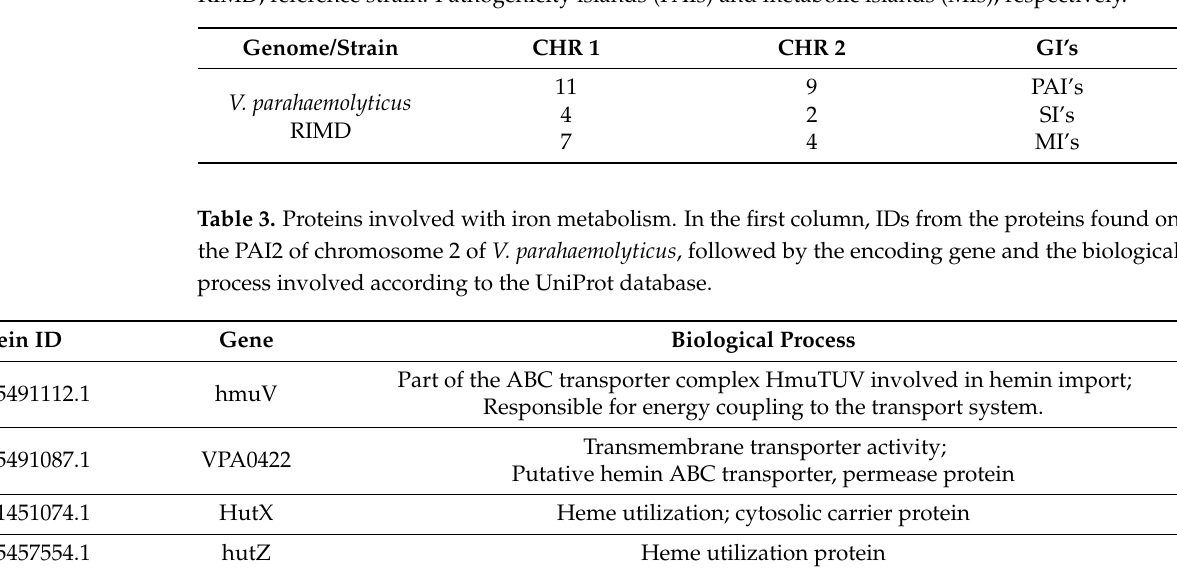
Table 2. Number of genomic islands (GIs) per chromosome in the genome of V. parahaemolyticus RIMD, reference strain. Pathogenicity islands (PAIs) and metabolic islands (MIs), respectively.